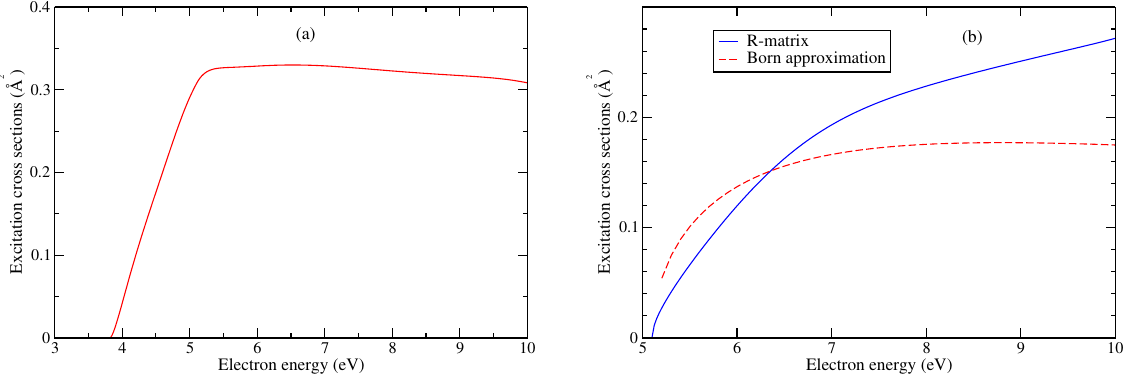
Figure 5. Electronic-excitation cross sections in 12-states CC model ( a ) ground to spin-forbidden transition transition 1 X → 3 Π and ( b ) ground to dipole-allowed transition transition 1 X → 1 Π , line curve; Born approximation, dashed curve.